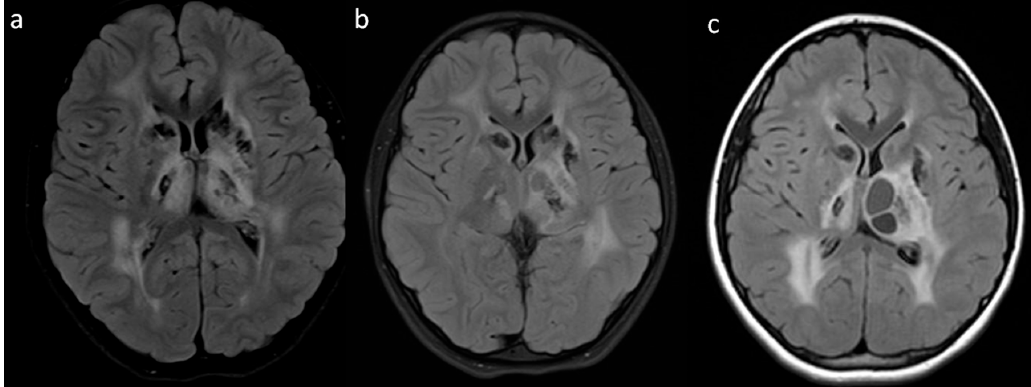
Figure 5. Follow-up MRI of the brain, axial plane in the T2 FLAIR sequence; ( a ) First MRI—at the age of 7 years; ( b ) Second MRI 6 months later; ( c ) Third MRI 1 year later—progression of calcifications, cysts in the left thalamus with the mass effect on MRI and white matter abnormalities.